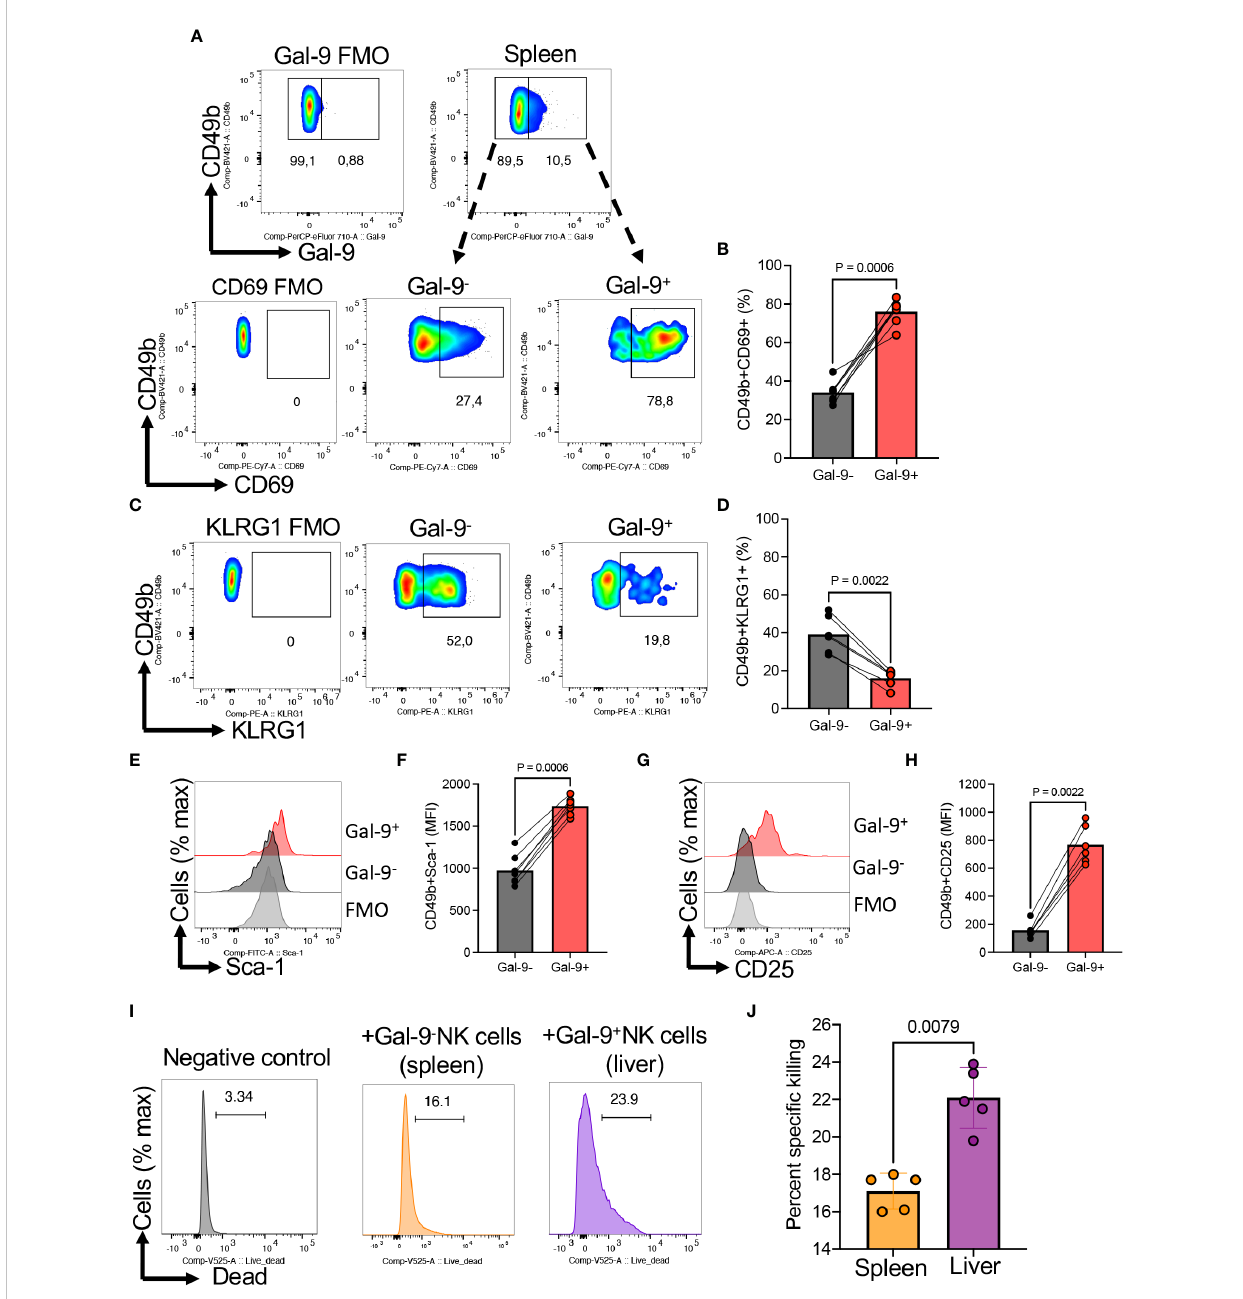
FIGURE 5 The expression of CD69, KLRG-1, Sca-1, and CD25 in Gal-9 + NK cells. (A) Representative fl ow cytometry plots, and (B) cumulative data of percentages of CD69 expressing NK cells among Gal-9 - or Gal-9 + NK cells of BALB/c mice. (C) Representative fl ow cytometry plots, and (D) cumulative data of percentages of KLRG1 expressing NK cells among Gal-9 - or Gal-9 + NK cells of BALB/c mice. (E) Representative fl ow cytometry plots, and (F) cumulative data of the intensity of Sca-1 expression among Gal-9 - or Gal-9 + NK cells of BALB/c mice. (G) Representative fl ow cytometry plots, and (H) cumulative data of the intensity of CD25 expression among Gal-9 - (splenocytes) or Gal-9 + (liver cells) NK cells of BALB/c mice . (I) Representative plots, and (J) cumulative data of percent speci fi c killing of target cells (RMA-s cells) in the presence and absence of Gal-9 + NK cells in splenocytes of mice. Each dot represents data from an animal, mean ± SEM from multiple independent experiments. The mean fl uorescence intensity (MFI). Fluorescence minus one